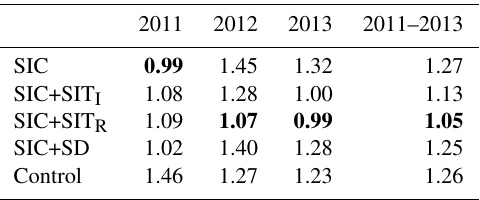
Table 3. The yearly averaged RMSE values of the five experiments compared to the IMB SIT buoy observations. Bold values represent the model with the lowest RMSE values for that year. No uncertain- ties are used to normalise the RMSE values.